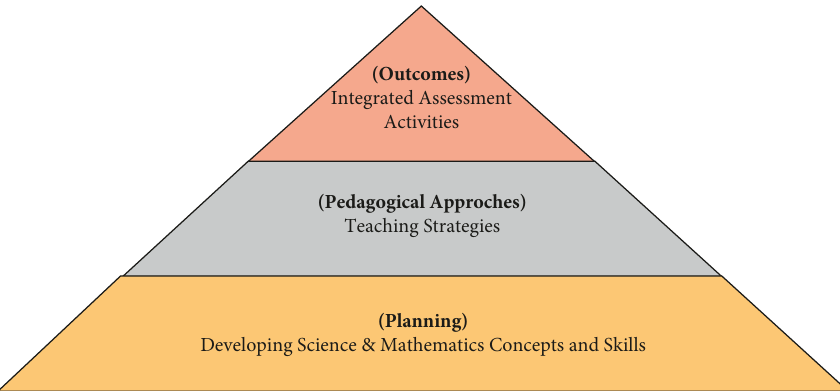
Figure 2: The adopted conceptual